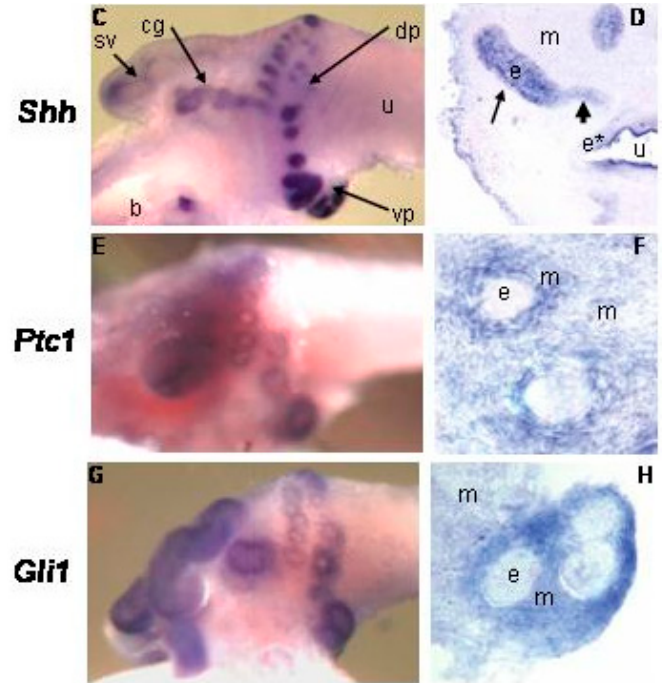
Figure 1. Whole mount in situ hybridization and sections of the P1 urogenital sinus (UGS). (m) mesenchyme (e) epithelium [4]